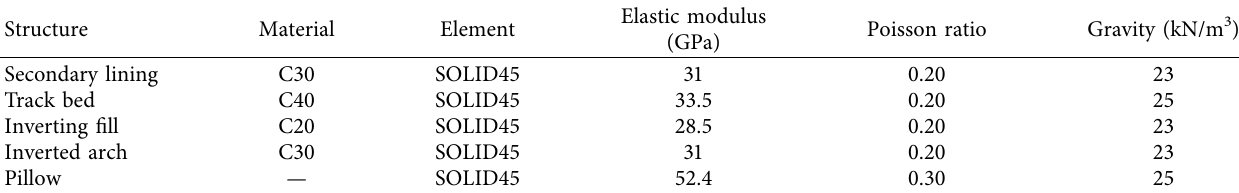
Table 6: Structural physical mechanics parameters.